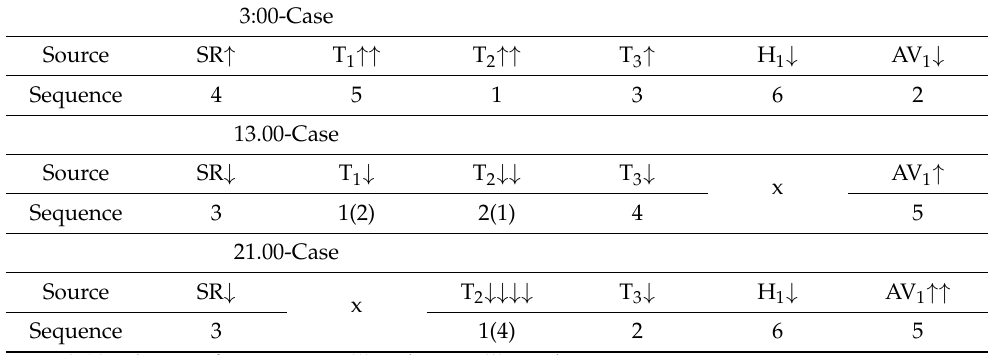
Table 12. Sources of microclimate regulation and their justified sequences in the observed